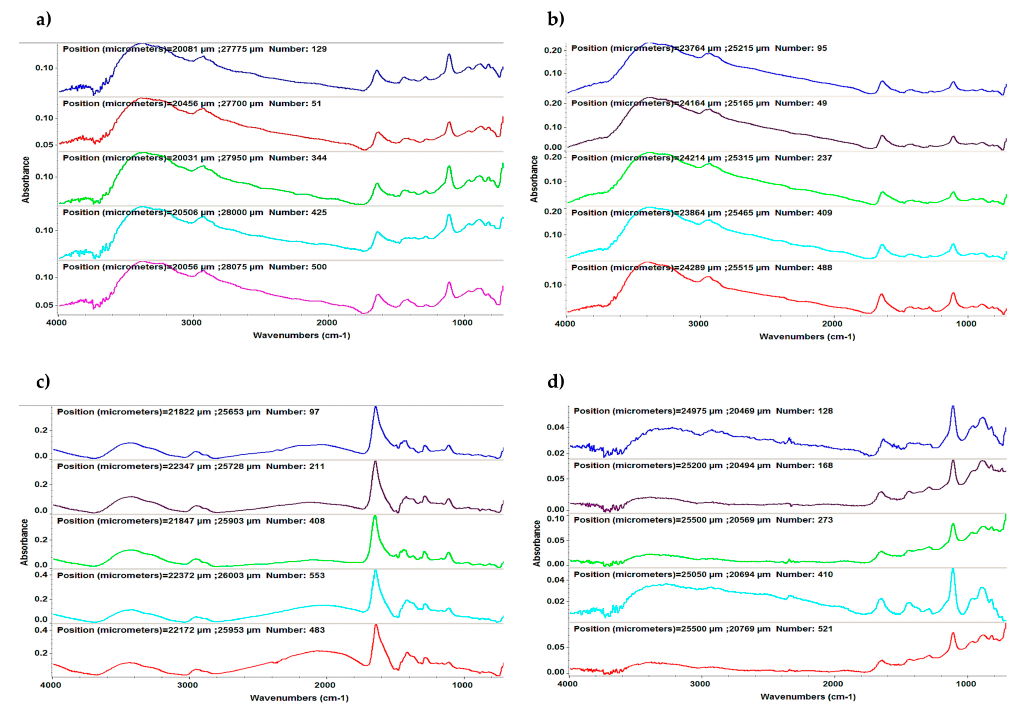
Figure 2. Typical Fourier-transform infrared spectroscopy (FTIR) spectra of MAPLE-deposited thin films: ( a ) polyvinylpyrrolidone–quercetin dihydrate–amphotericin B, ( b ) polyvinylpyrrolidone–resveratrol–amphotericin B, ( c ) polyvinylpyrrolidone–quercetin dihydrate–voriconazole, and ( d ) polyvinylpyrrolidone–